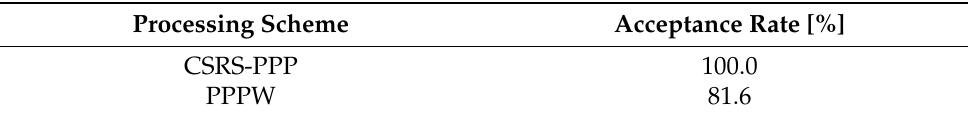
Table 9. Acceptance rates for the GNSS-ZTD results of CSRS-PPP and PPPW for